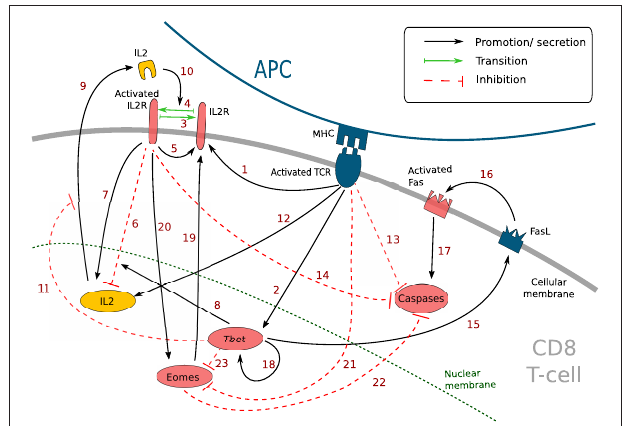
FIGURE 1 | Simplified molecular regulatory network in a CD8 T-cell. Red molecular factors dynamics are described by Equations (1–6); yellow molecular factors dynamics are described by Equation (7); black arrows: promotion or secretion; green arrows: transition between activated and non-activated form of IL2R; red dashed arrows: inhibition. The meaning of the numbered arrows is reported in Table 1